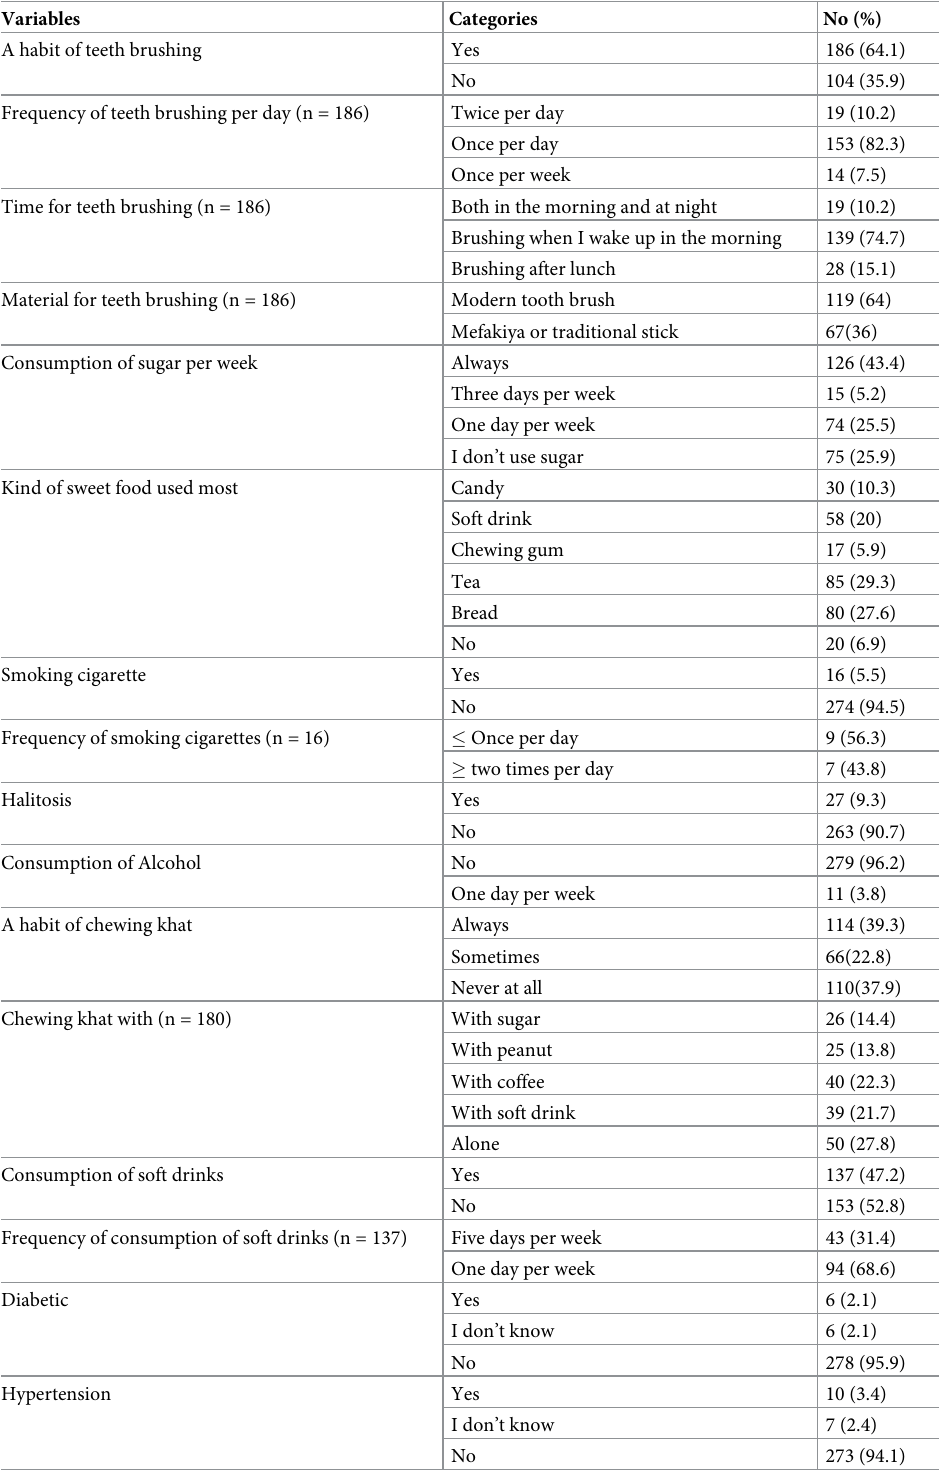
Table 2. Behavioral and health-related factors of the dental caries patients attended at Hiwot Fana comprehensive specialized university hospital dental clinic (N = 290), Eastern Ethiopia from April to June